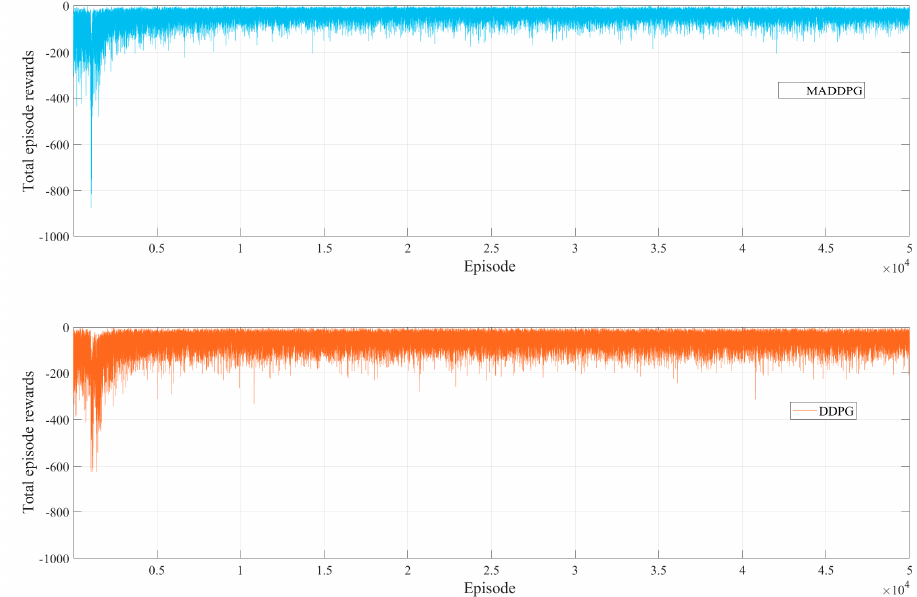
Figure 4. The total episode rewards obtained by the 3-agent MADDPG algorithm and the single-agent DDPG algorithm over 50,000 episodes.